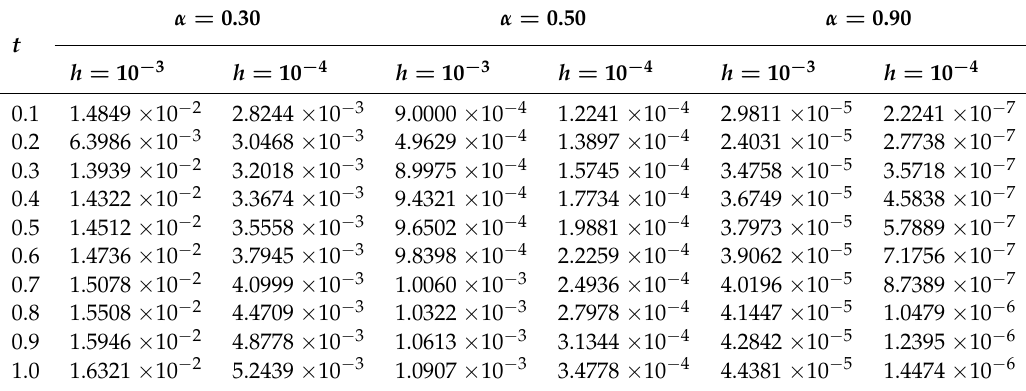
Table 4. Absolute error at each point, t when solving Example 2 using FEAM3 for different step size, h and 0 < α < 1.